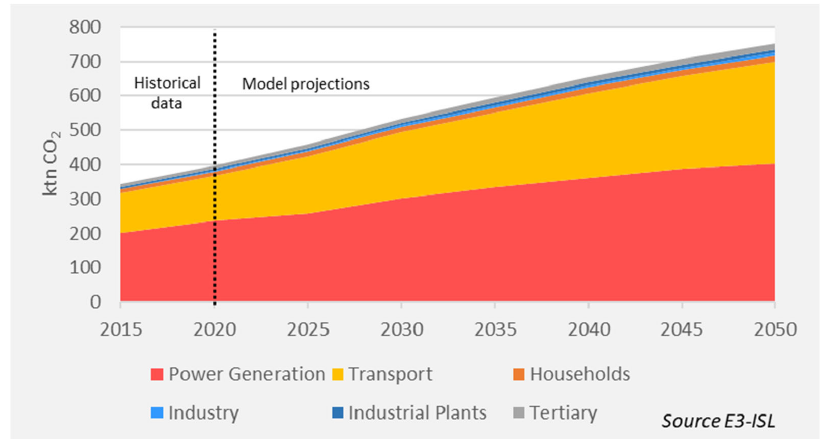
Figure 11 . Baseline—energy ‐ related CO2 emissions by sector . Figure 11. Baseline—energy-related CO